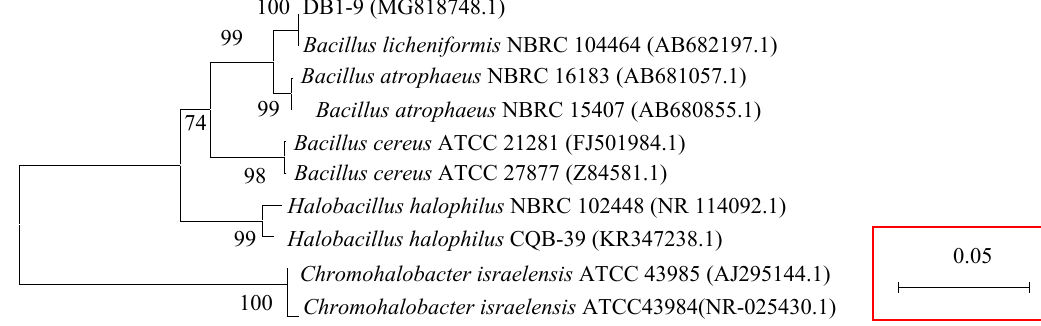
Figure 1. Phylogenetic tree constructed with the neighbor-joining method based on bacterial 16S rDNA sequence alignment.